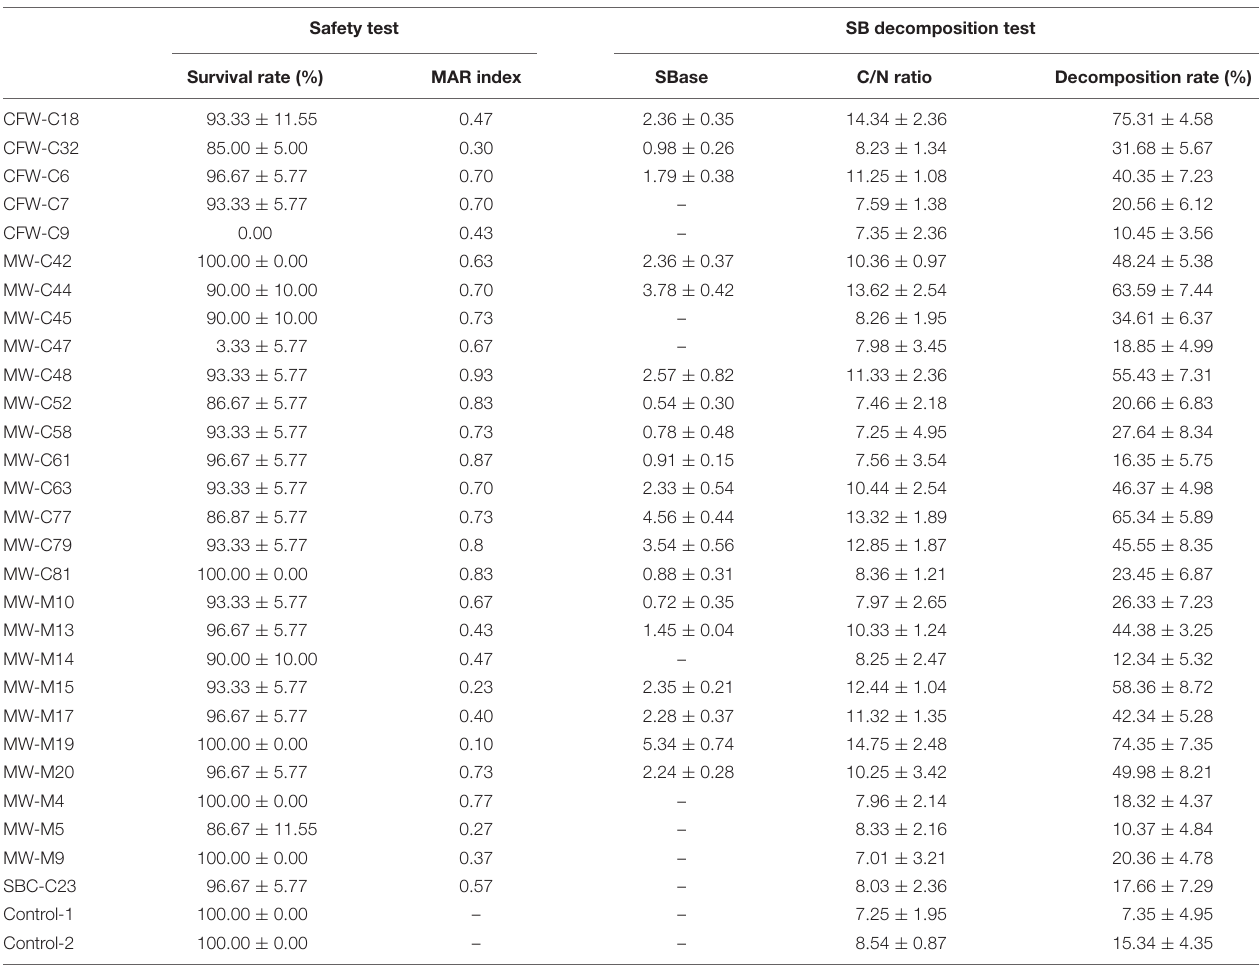
TABLE 2 | The safety evaluation of cellulolytic bacteria and the SB decomposition of cellulolytic bacteria after rearing shrimps for 1 week in small-scale laboratory